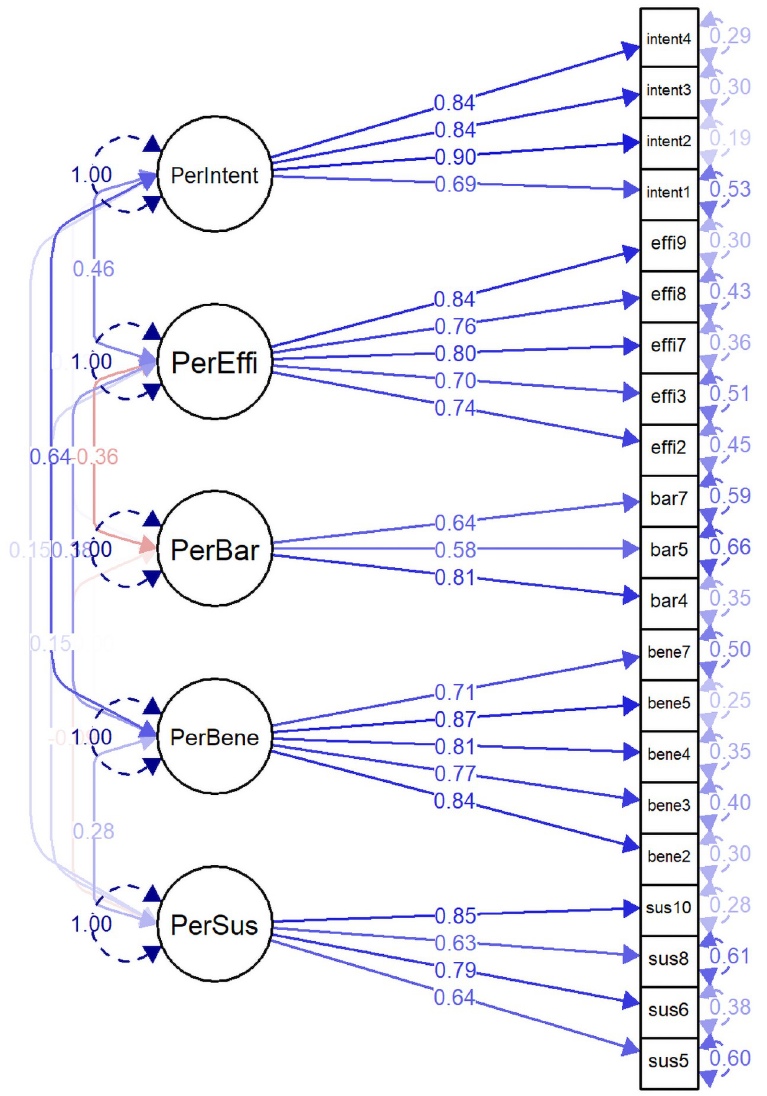
Fig 3. Perceived risk constructs of developing non-communicable diseases (Five-factor